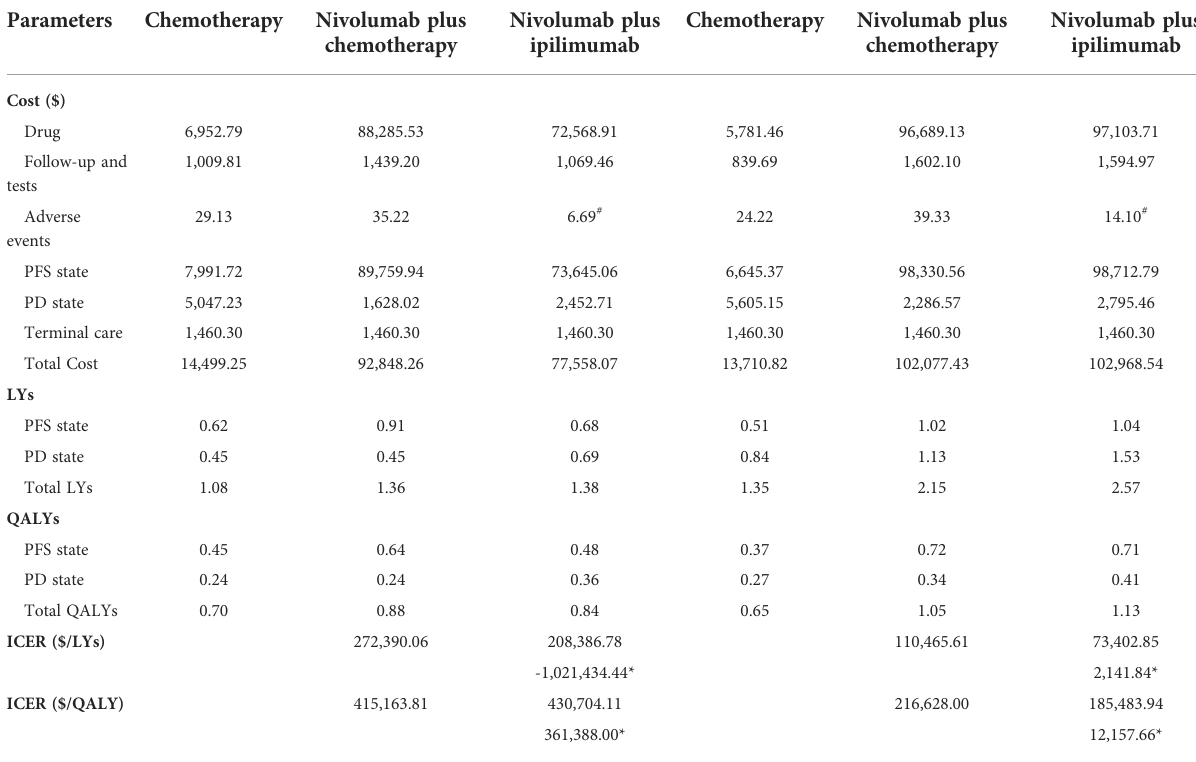
TABLE 3 Base case results.